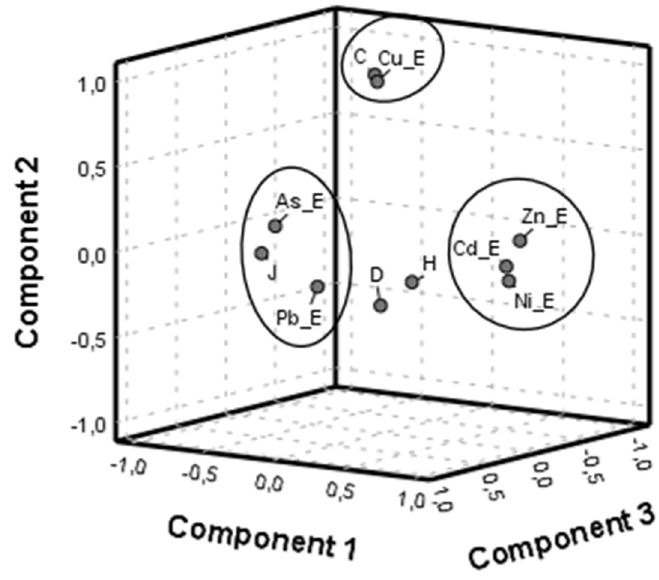
Figure 5. Principal component analysis (PCA) with varimax rotation based on the analysed parameters. PTEs in their salt efflorescence in solid form (E): Ni_E, Cu_E, Zn_E, As_E, Cd_E, Pb_E; D = divalent metal(loid) sulphate minerals; H = halotrichite group minerals; C = copiapite group minerals; J = jarosite group minerals.